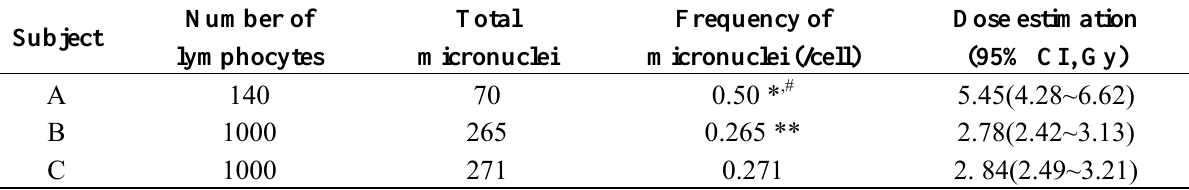
Table 3. CBMN assay and biological dose